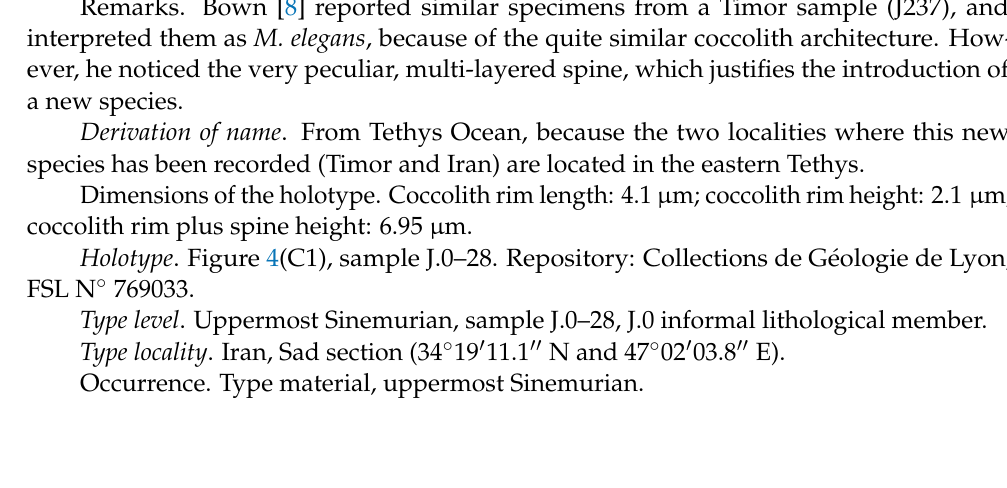
Holotype . Figure 4(C1), sample J.0–28. Repository: Collections de G é ologie de Lyon, FSL N ◦